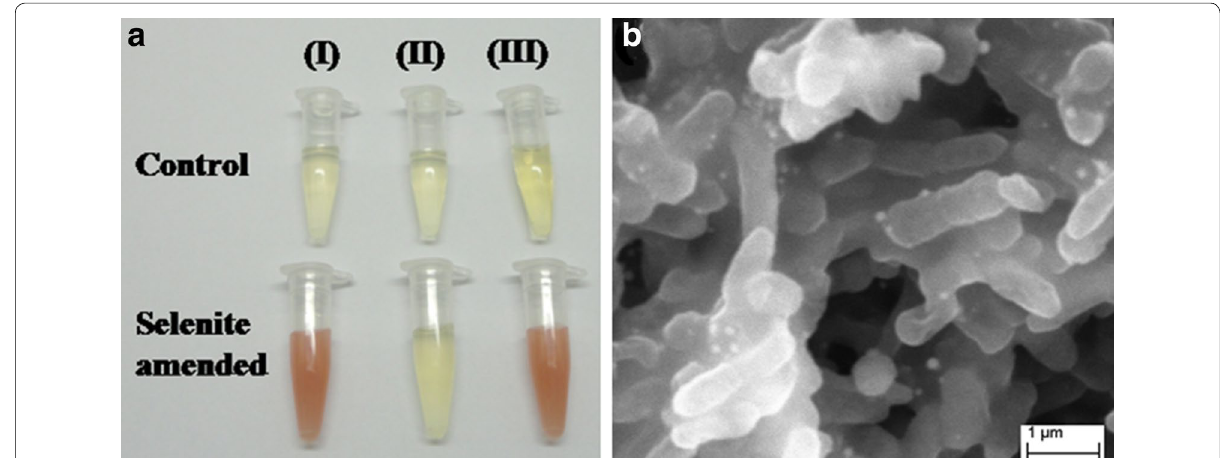
Fig. 8 a Localization of selenite reductase activity in various fractions of control and selenite-amended reaction mixtures; (I) Supernatant, (II) cytosolic, and (III) membrane fractions and b SEM picture indicating the selenium nanospheres adhered bacterial